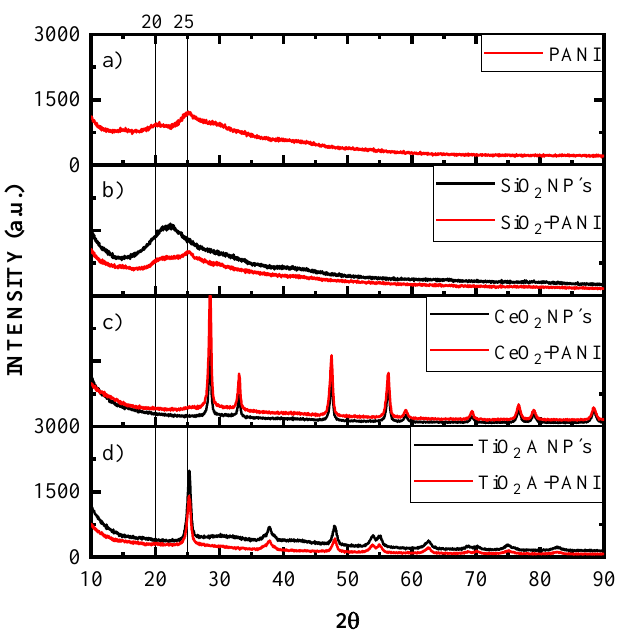
Figure 4. XRD patterns of ( a ) PANI, ( b ) SiO 2 , SiO 2 -PANI, ( c ) CeO 2 , CeO 2 -PANI, and ( d ) TiO 2 A, TiO 2 A-PANI; nanoparticles (black) and nanocomposites (red).